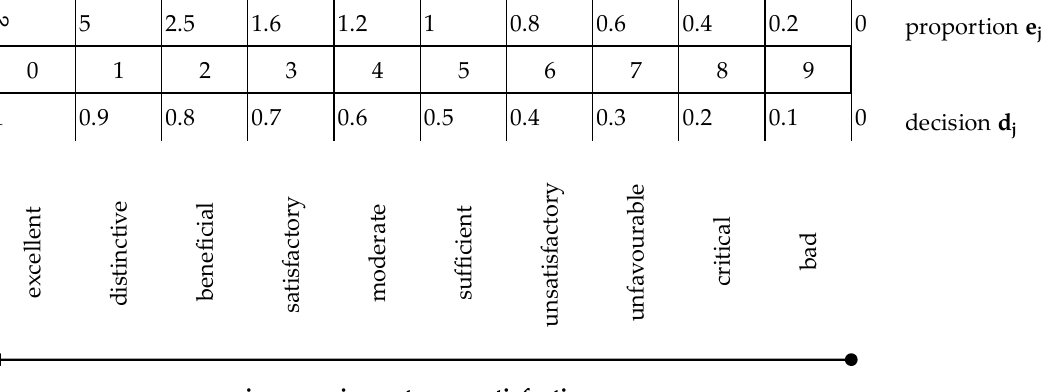
Figure 5. Relative states scale. Own study, based on [4,47–50].